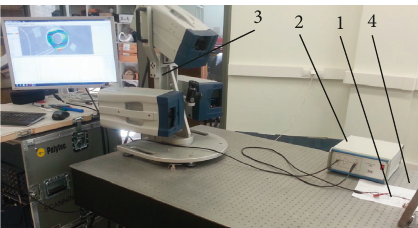
Figure 12: Experimental setup: 1, piezoelectric transducer; 2, liner amplifier P200; 3, 3D scanning vibrometer PSV-500-3D-HV; 4, support of the measured object.